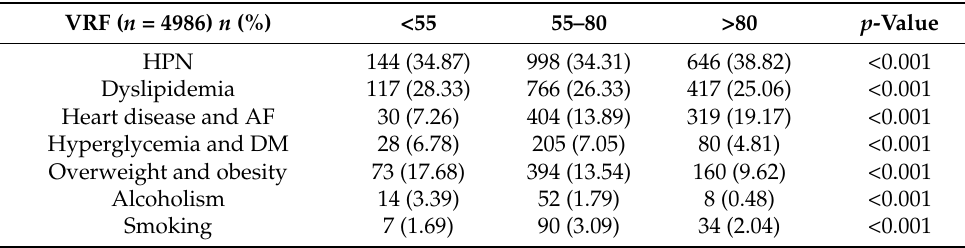
Table 2. Distribution of vascular risk factors according to age group.